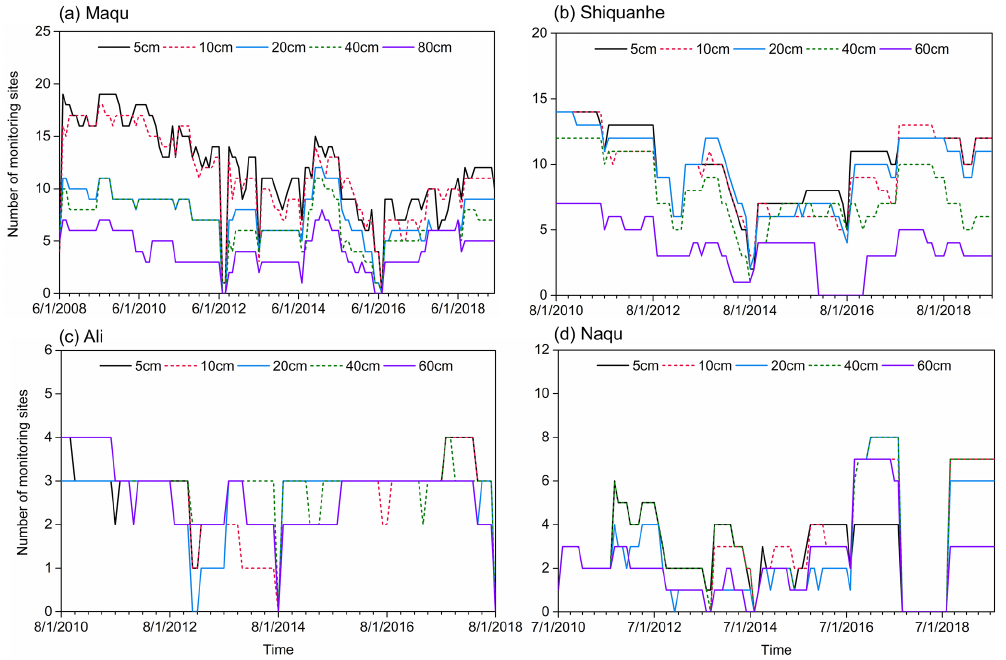
Figure 2. Number of available SMST monitoring sites for different depths at each month for the (a) Maqu, (b) Shiquanhe, (c) Ali, and (d) Naqu